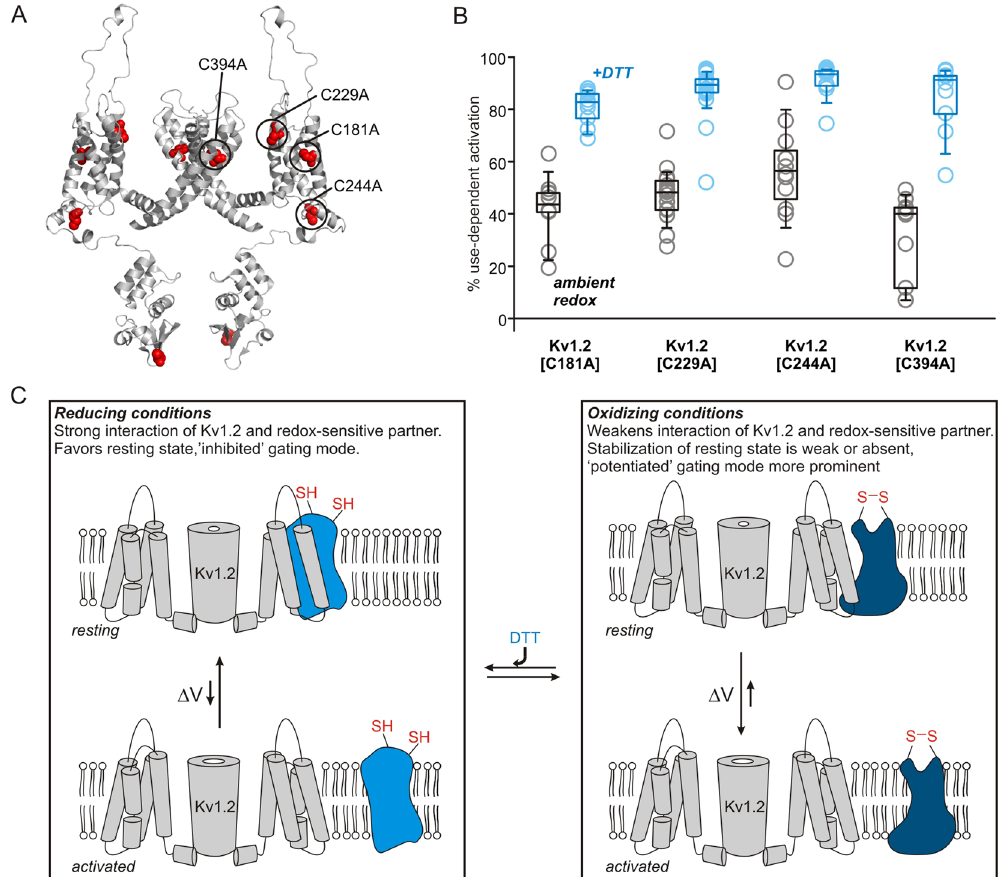
Figure 5. Systematic mutagenesis of transmembrane cysteine residues in Kv1.2. ( A ) Cysteine residues are highlighted in red on the Kv1.2 structure (PDB 3LUT). C181, C229, C244, and C394 in the transmembrane domains were mutated to alanine. ( B ) Use-dependent activation of each cysteine mutant was assessed with trains of repetitive depolarizations, as described in Fig. 1, in ambient redox and after incubation in 666 µ M DTT (N = 10–22 for each condition). ( C ) Schematic model depicting redox dependent interactions of Kv1.2 with a postulated extrinsic binding partner (blue) that mediates use-dependent activation. We propose that the reduced state of the regulatory partner has a high affinity for the Kv1.2 channel that promotes an inhibited gating mode by stabilizing the resting conformation. In more oxidizing conditions, the regulatory partner has weakened or altered interactions with Kv1.2, causing the inhibited gating mode to be less